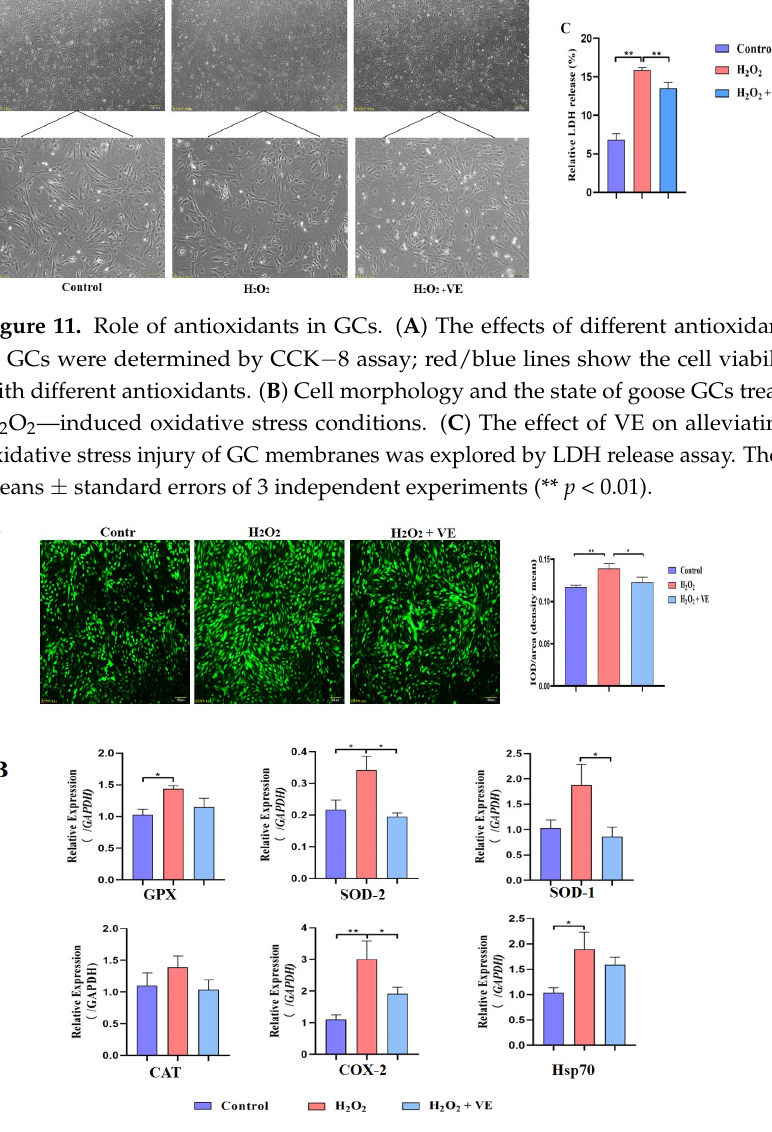
Figure 12. Mechanisms of action of VE antioxidants under H 2 O 2 -induced oxidative stress. ( A ) Fluorescence probe staining of ROS observed by fluorescence microscopy at 488 nm and relative fluorescence intensity of ROS. Left: representative images of ROS staining; right: ROS fluorescence intensity. ( B ) Expression of GPX, SOD-1 , SOD-2 , CAT, COX-2 and Hsp70 in VE-treated GCs exposed to H 2 O 2 -induced oxidative stress ( n = 3). The values are the means ± standard deviations of all the experiments. The data represent the means ± standard errors of 3 independent experiments (* p < 0.05; ** p < 0.01).